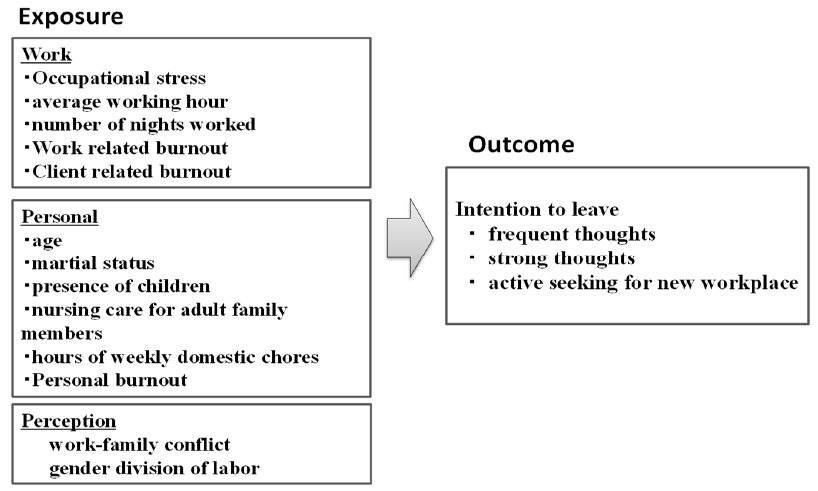
Figure 1. The theoretical framework and hypothesis of this study. Conceptual framework for nurse’s intention to leave the workplace.